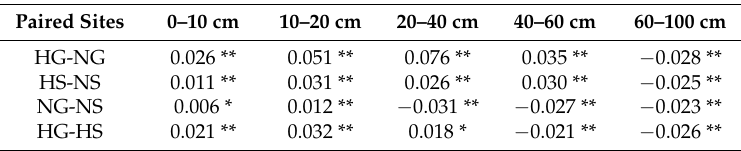
Table 2 . The paired sample T-test of monthly average VWC. Table 2. The paired sample T-test of monthly average VWC. Paired